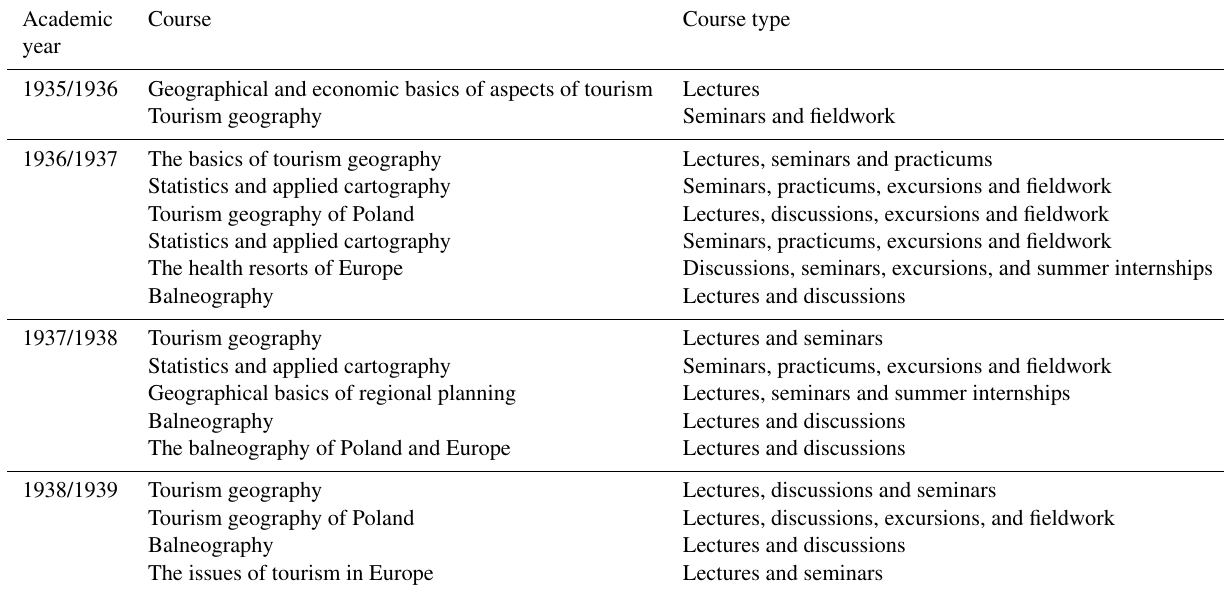
Table 1. Tourism education at the Jagiellonian University School of Tourism (source: authors’ own work based on archival materials of the